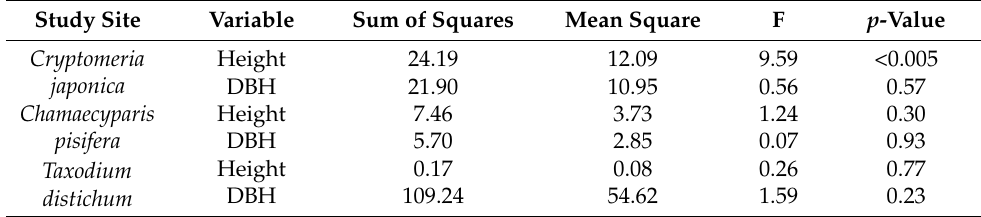
Table 8. Results of one-way ANOVA analysis by device.